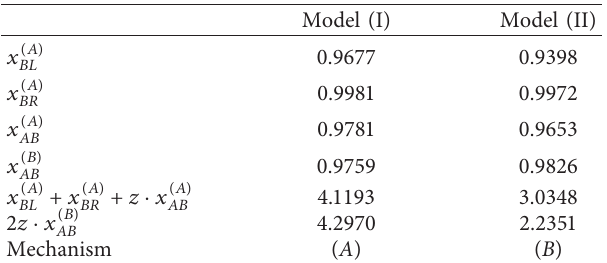
Table 2: The results of the moment-shear interaction and deter- mining the type of